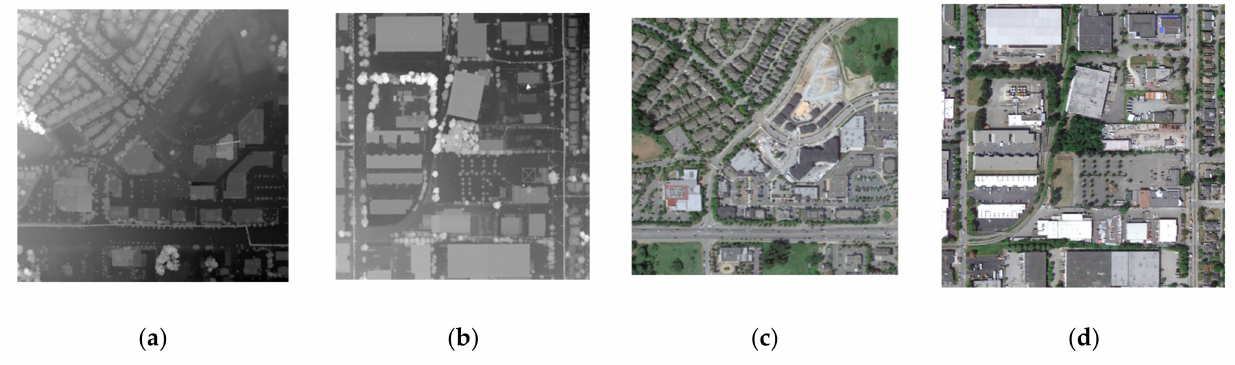
Figure 14. Test data from DALES datasets: ( a ) test LiDAR data 1; ( b ) test LiDAR data 2; ( c ) aerial image 1; ( d ) aerial image 2.